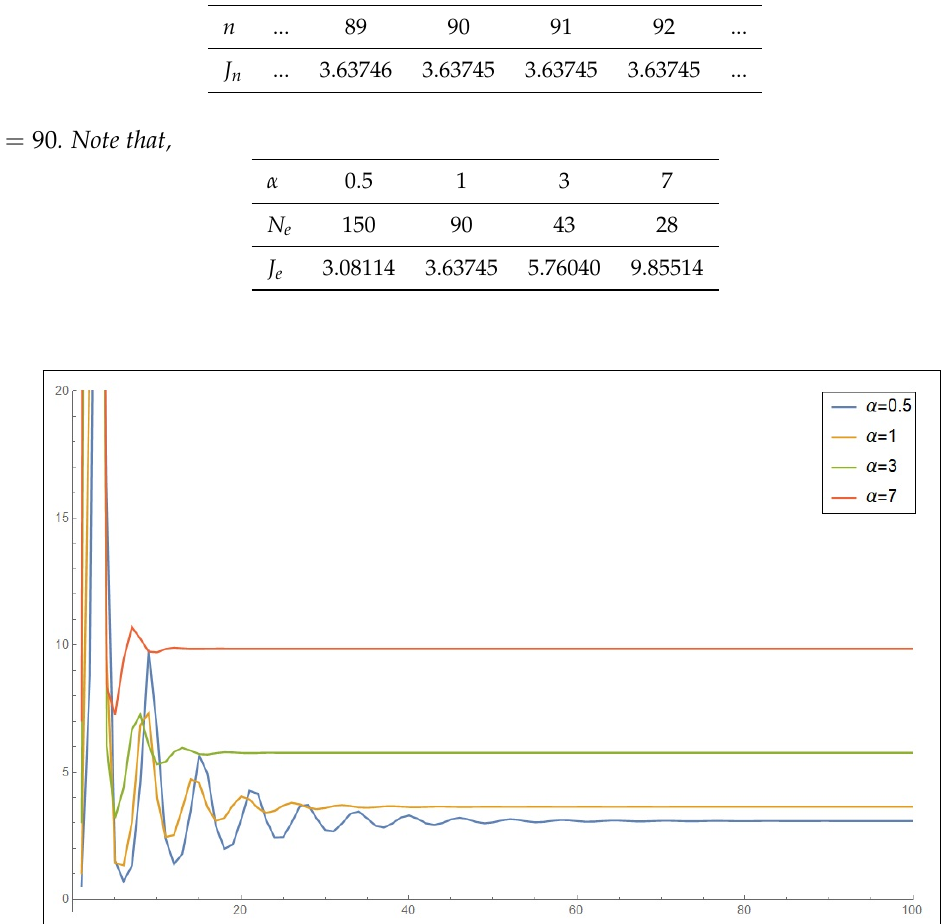
Figure 1. Figure 1. The stable solution of Equation (22) when α = 0.5, 1, 3 and